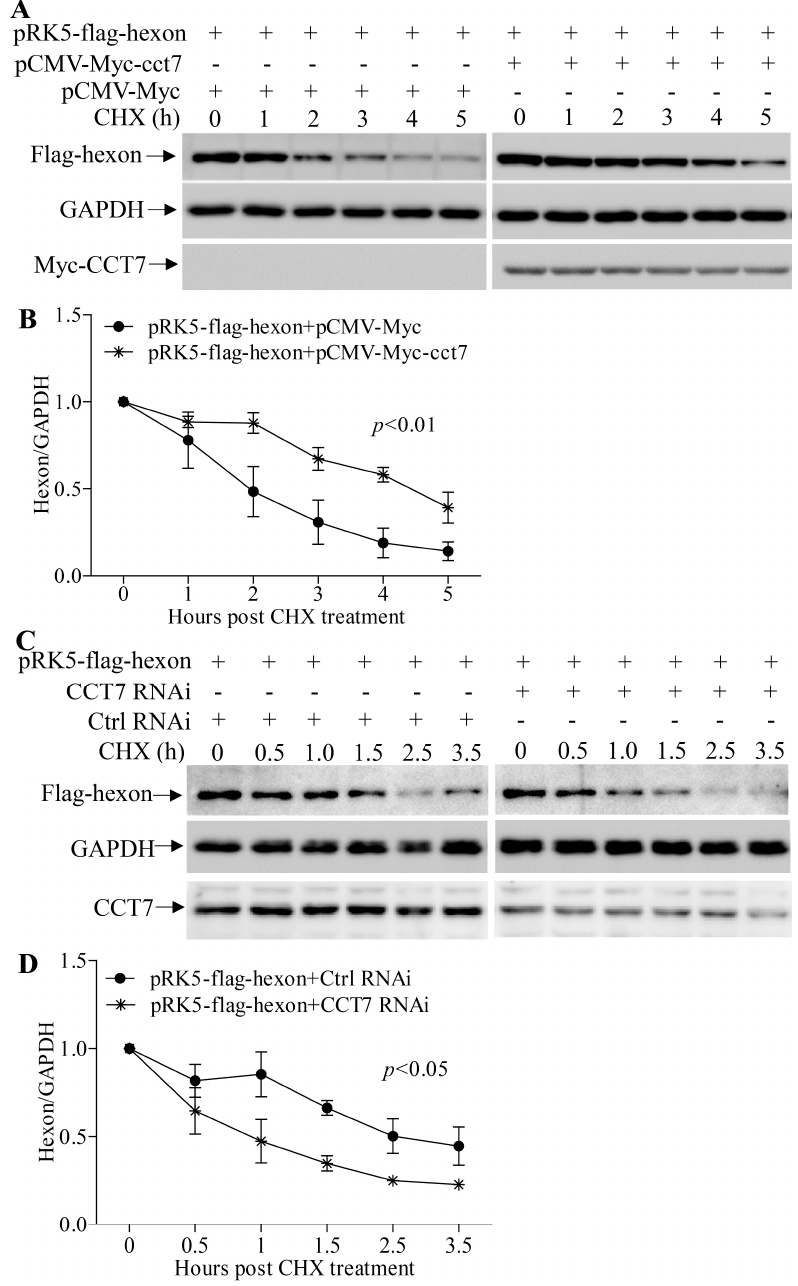
Figure 7. Involvement of CCT7 in hexon reduction in LMH cells. ( A , B ) LMH cells were cotransfected with pCMV-Myc-cct7 and pRK5-flag-hexon or control empty vector. Twelve hours after transfection, cells were treated with cycloheximide (CHX, 50 μ g/mL) at different time points (0, 1, 2, 3, 4, and 5 h) before being harvested. Cell lysates were prepared and examined with Western Blot using the